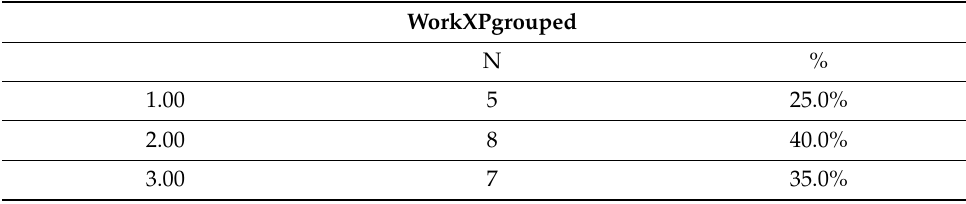
Table 1. Participants divided by work